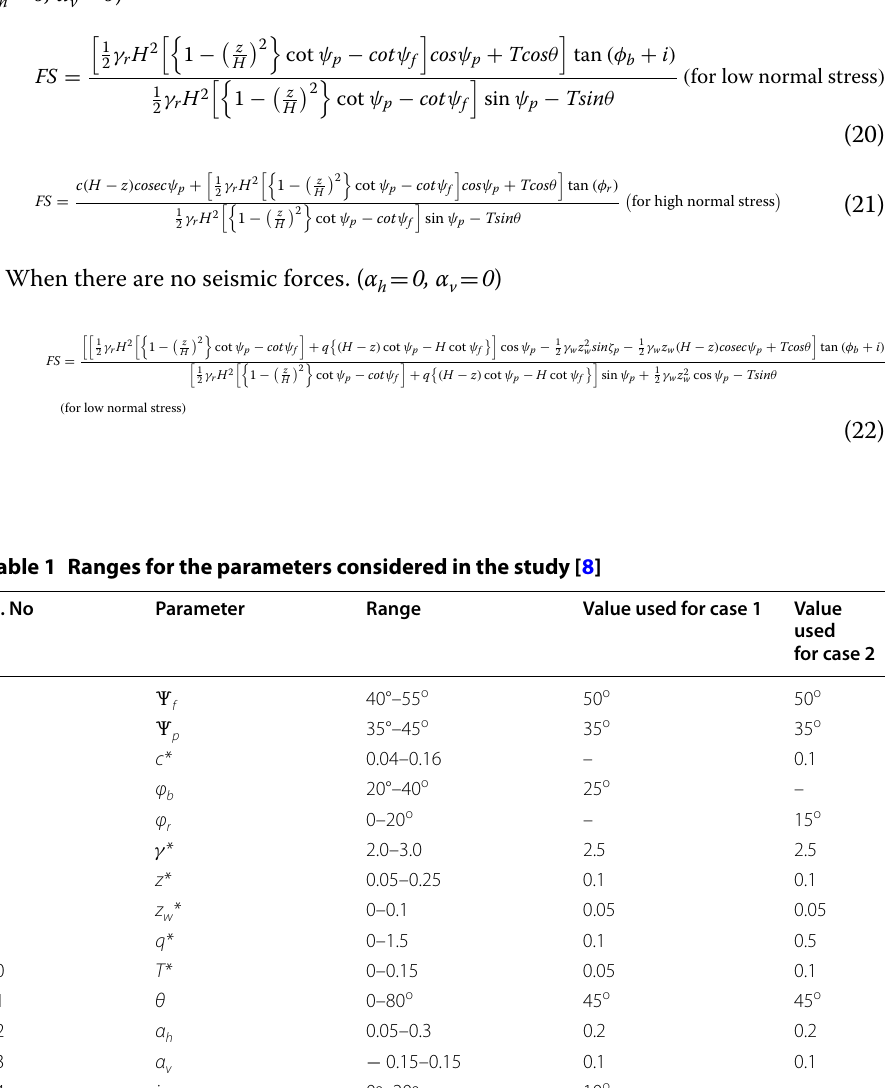
When there is no water in tension crack, surcharge and seismic forces ( z w 0, α v 0 ) α h = =